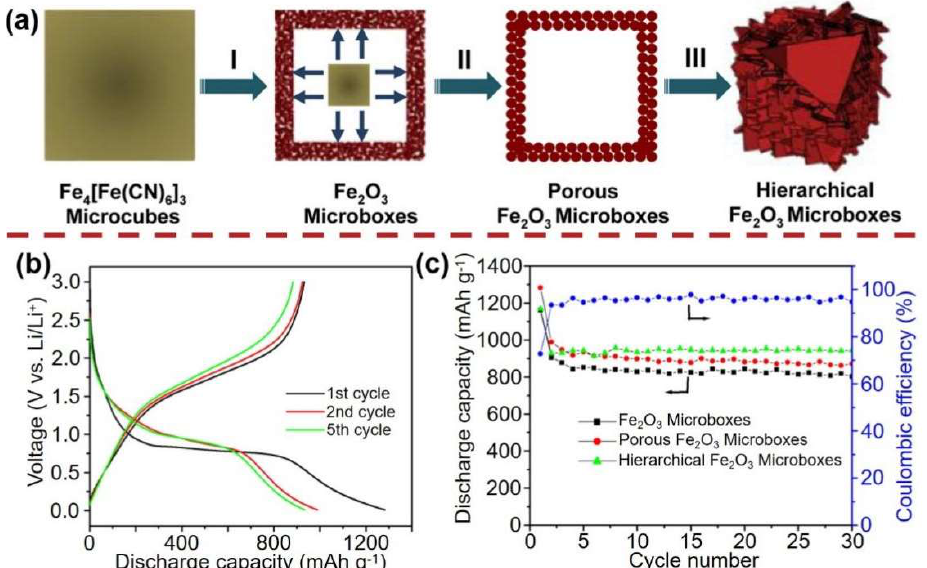
Figure 2. ( a ) Schematic illustration of the formation of hollow Fe 2 O 3 microboxes and the evolution of the shell structure with the increasing calcination temperature. ( I At temperatures below 350 ◦ C, PB is converted to iron oxide in the near-surface region. II When the annealing temperature rises to 550 ◦ C, the Fe 2 O 3 microcapsules change into highly porous microcapsules. III When the annealing temperature rises to 650 ◦ C, the highly porous shell is transformed into a layered shell composed of Fe 2 O 3 nanoflakes.) ( b ) Discharge-charge voltage profiles of porous Fe 2 O 3 microboxes obtained at 550 ◦ C. ( c ) Cycling performance of Fe 2 O 3 microboxes (350 ◦ C), porous Fe 2 O 3 microboxes (550 ◦ C), and hierarchical Fe 2 O 3 microboxes (650 ◦ C), and Coulombic efficiency of porous Fe 2 O 3 microboxes (550 ◦ C) over the voltage range 0.01–3.0 V and Li/Li + at the same current density of 200 mA g − 1 . Ref. [12] Copyright Journal of the American Chemical Society, ACS